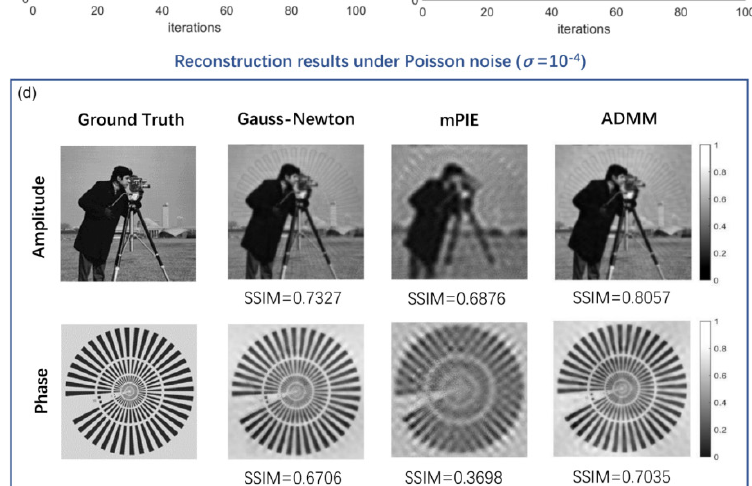
Figure 4. Comparison of simulated reconstruction results under Poisson noise. ( a1 , a2 ) Amplitude and phase SSIM curves as a function of Poisson noise level. ( b1 , b2 ) Amplitude and phase SSIM curves as a function of iteration numbers under Poisson noise ( σ = 10 − 3 ). ( c1 , c2 ) Amplitude and phase SSIM curves as a function of iteration numbers under Poisson noise ( σ = 10 − 4 ). ( d ) Visual reconstruction results of three algorithms under Poisson noise ( σ = 10 − 4 ) with SSIM values marked below the images.